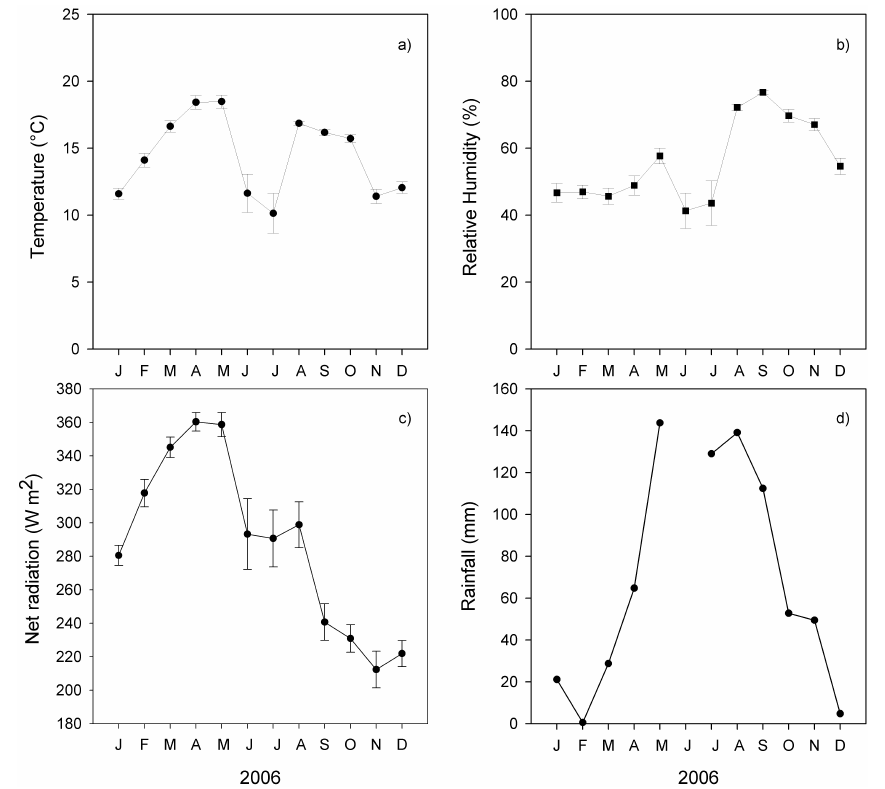
Fig. 1. Monthly means and standard errors for 24h records of: (a) air temperature ( T ), (b) relative humidity (RH), (c) net radiation and, (d) rainfall at the study